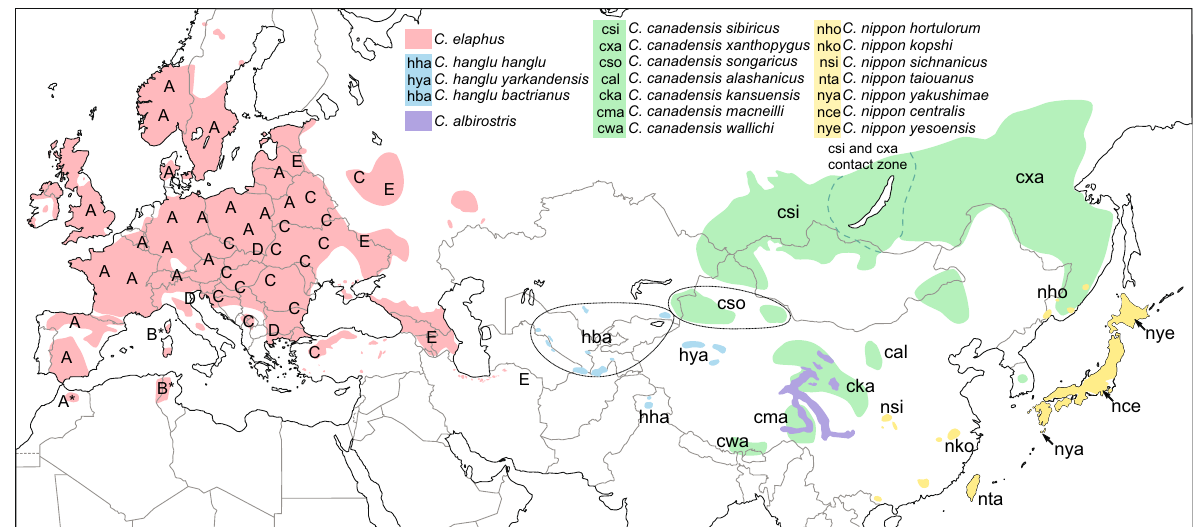
Figure 1. Contemporary distribution of Cervus species and subspecies. Haplogroups (rather than subspecies) of C. elaphus (Western red deer) are marked as letters A-E. Deer haplogroups introduced to selected regions are marked with an asterisk*. The distribution ranges were compiled from several sources 2,104–119 . Figure was created in CorelDRAW Graphics Suite 11 (https:// www. corel draw. com/ en/) based on OpenStreetMap (URL https:// www. opens treet map. org/ copyr ight; ODbL licence 1.0 https:// opend ataco mmons. org/ licen ses/ odbl/1- 0/ by